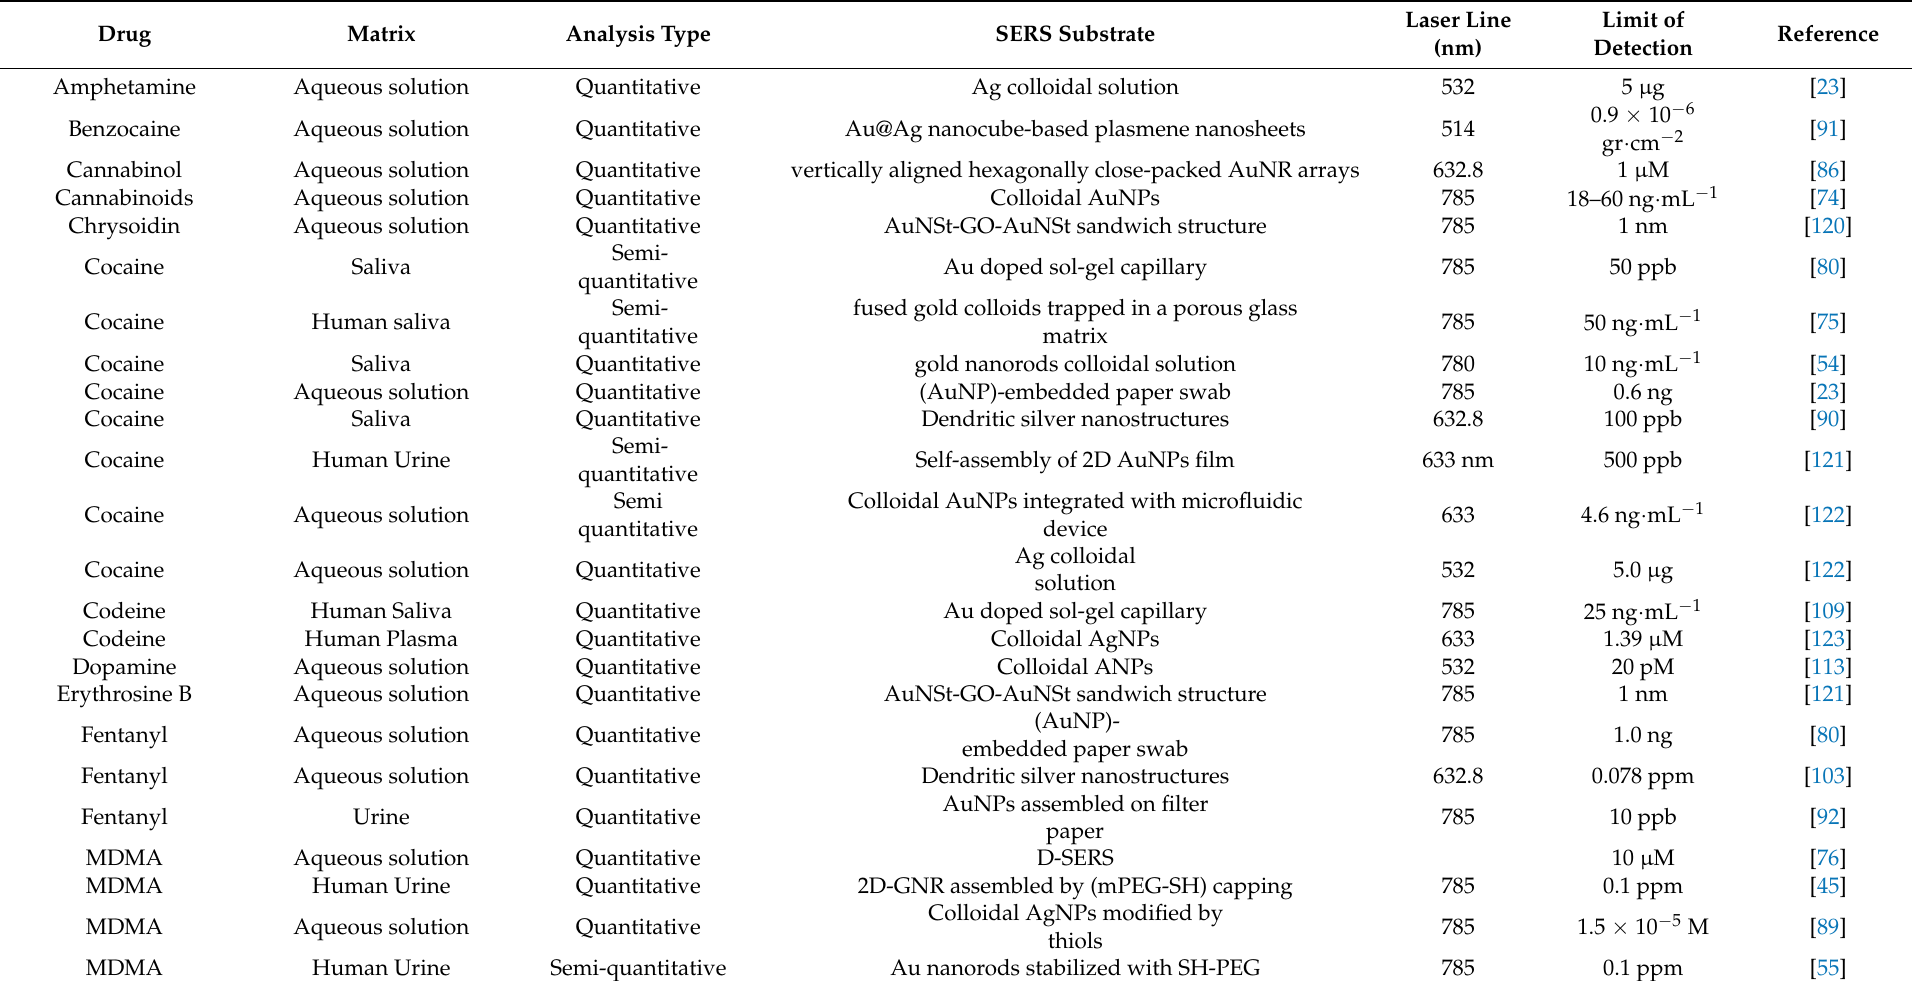
Table 2. Applications of SERS analyses of illicit drug